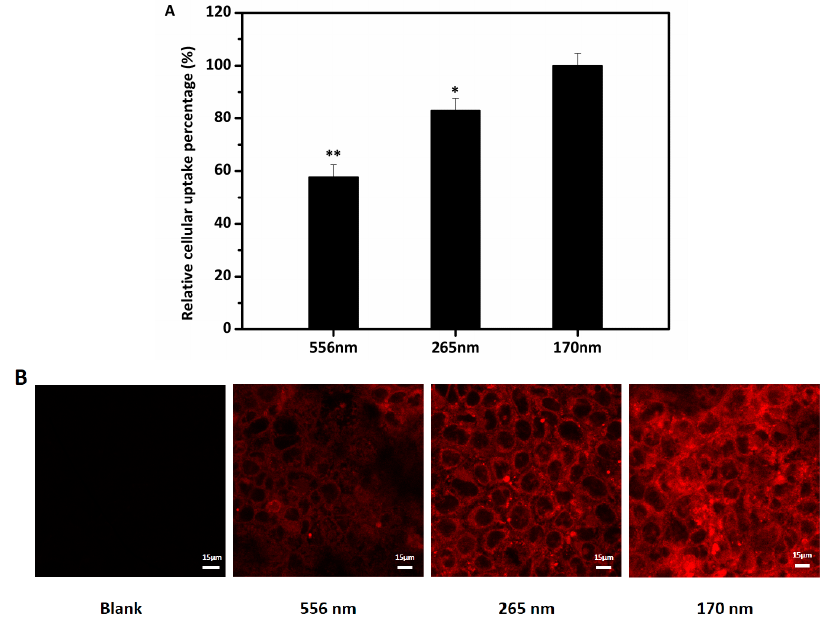
Figure 6. The effects of three different droplet sizes on cellular uptake of lipid-based emulsions ( A ) Relative uptake of emulsions of different diameters by Caco-2 cells. The 170 nanoemulsions were used as control (100% uptake). Other lipid emulsion sizes were compared to the control using ANOVA (* p < 0.05, ** p < 0.01). ( B ) CLSM of Caco-2 cells grown on glass coverslips after exposure to three different droplet size lipid-based emulsions containing Nile red for 4 h. Scale bar indicates 15 μ m. The data were expressed as mean ± standard with three independent replicates.